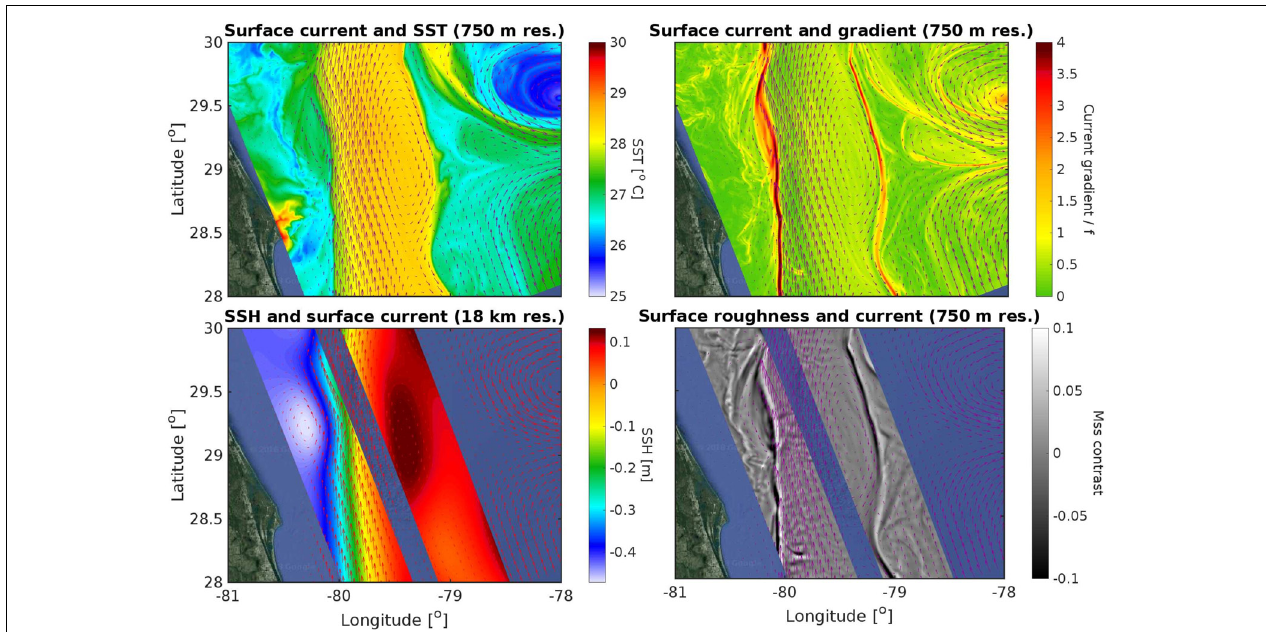
FIGURE 7 | Numerical simulations over the Gulf Stream to illustrate the possible synergetic use of SWOT SSH (averaged at 18 km, bottom left) and SWOT backscatter (averaged at 750 m, bottom right). Geostrophy at 18 km resolution does not reproduce frontal structures (bottom left, red arrows), with weak current gradients, always well below the Coriolis frequency f (not shown). The backscatter at sub-kilometer resolution (bottom right) provides information on the location and amplitude of the intense current gradients (top right) ( Credits: Ifremer